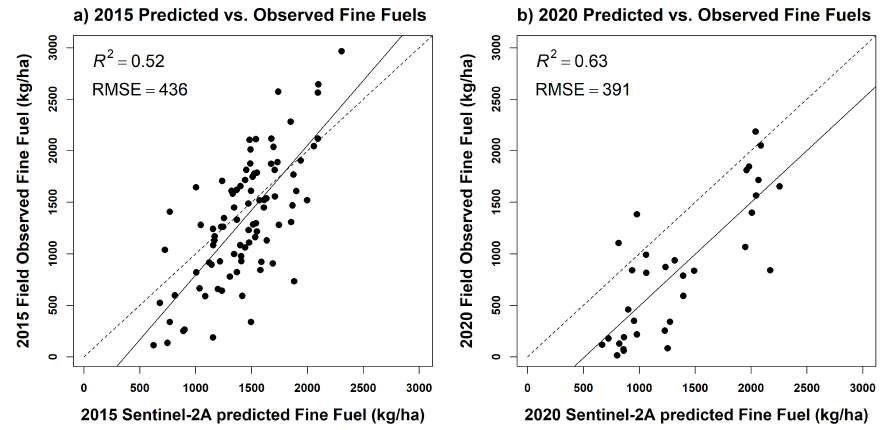
Figure 3. Validation of Sentinel-2A models of predicted fine-fuels (kg/ha) vs. observed field estimates of fine-fuels (kg/ha) for ( a ) 2015 validation test data ( n = 90) and ( b ) 2020 validation data ( n = 35) using general linear models (solid line); 1:1 line forced through the origin (dashed line) shown for reference.